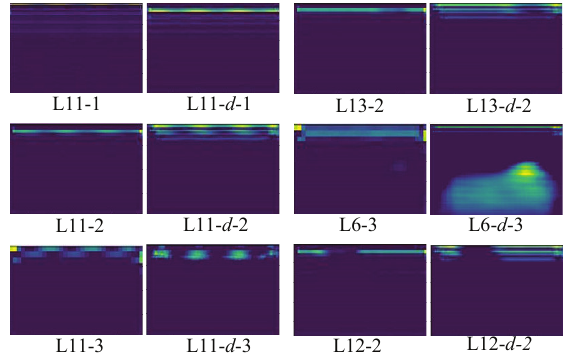
Figure 7. Deconvnet analysis on the features of RDCA-3.